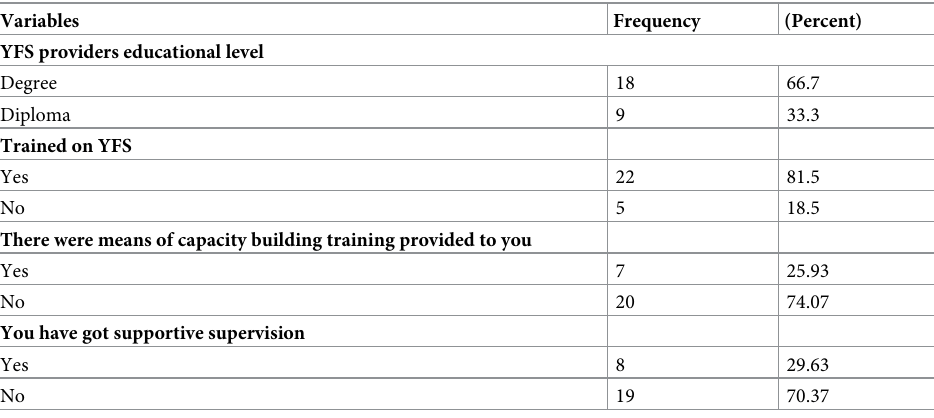
Table 2. Characteristics of the YFS providers, Northwest Ethiopia, 2019.